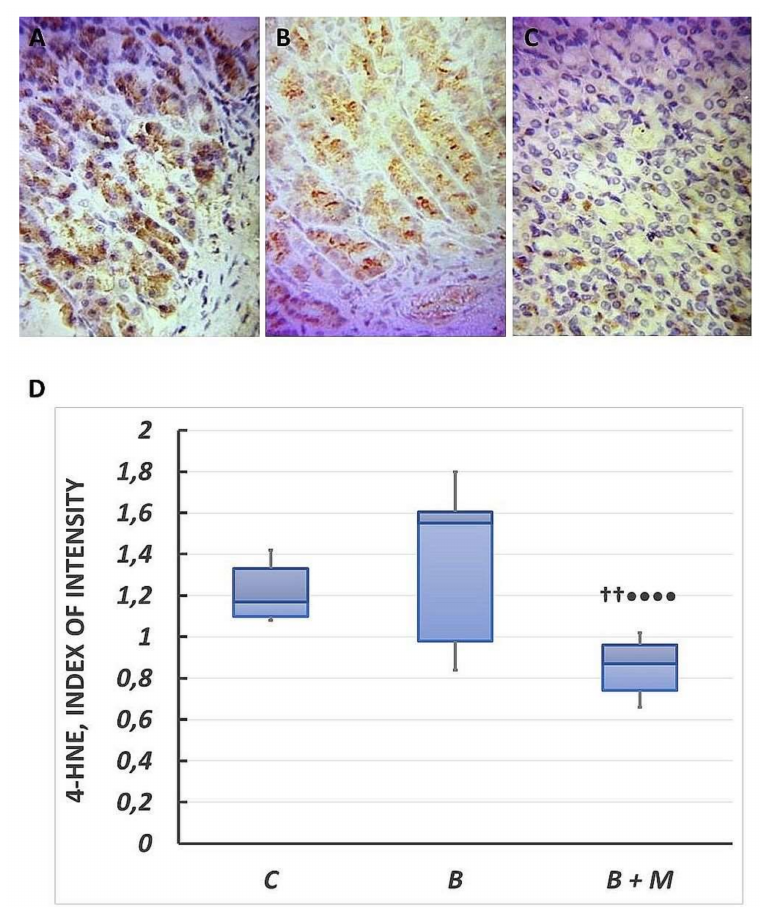
Figure 1. Melatonin effect on 4-HNE expression. Immunohistochemical 4-HNE detection in gastric mucosa. Controls ( A ); burned rats ( B ); burned melatonin-treated rats ( C ). The antigen site appears as a brown color. Representative images. Original magnification, 400 × . Score index of 4-HNE positive immunostained cells ( D ). Results are given as box plot, with median, 25th- and 75th-percentile values, and min and max values. †† p < 0.01 vs. burned, non-treated group; •••• p < 0.0001 vs. control group. Controls (C); burned rats (B); burned melatonin-treated rats (B +